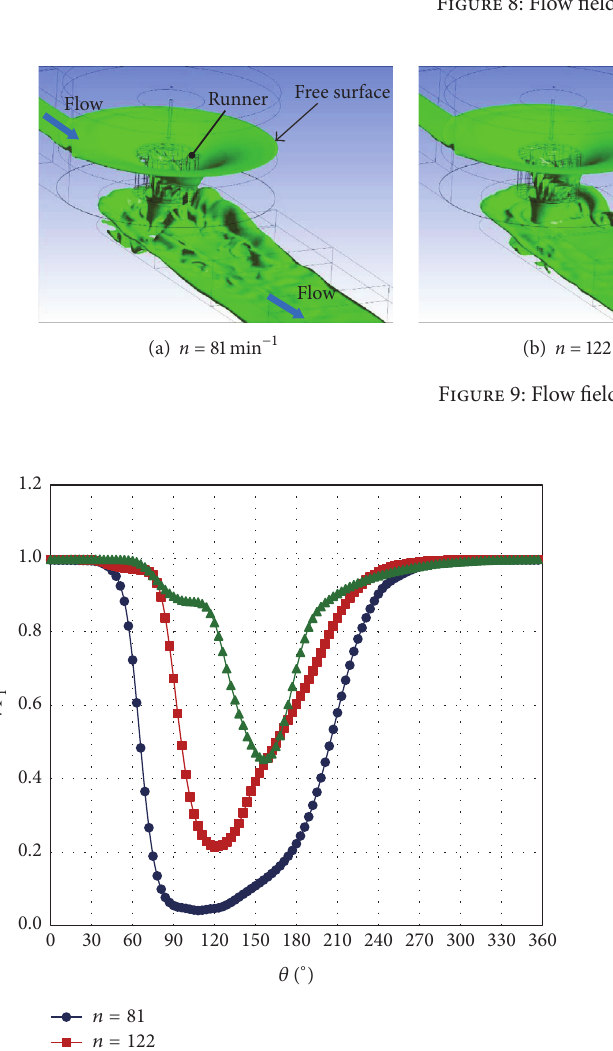
Figure 8: Flow field by experiment.